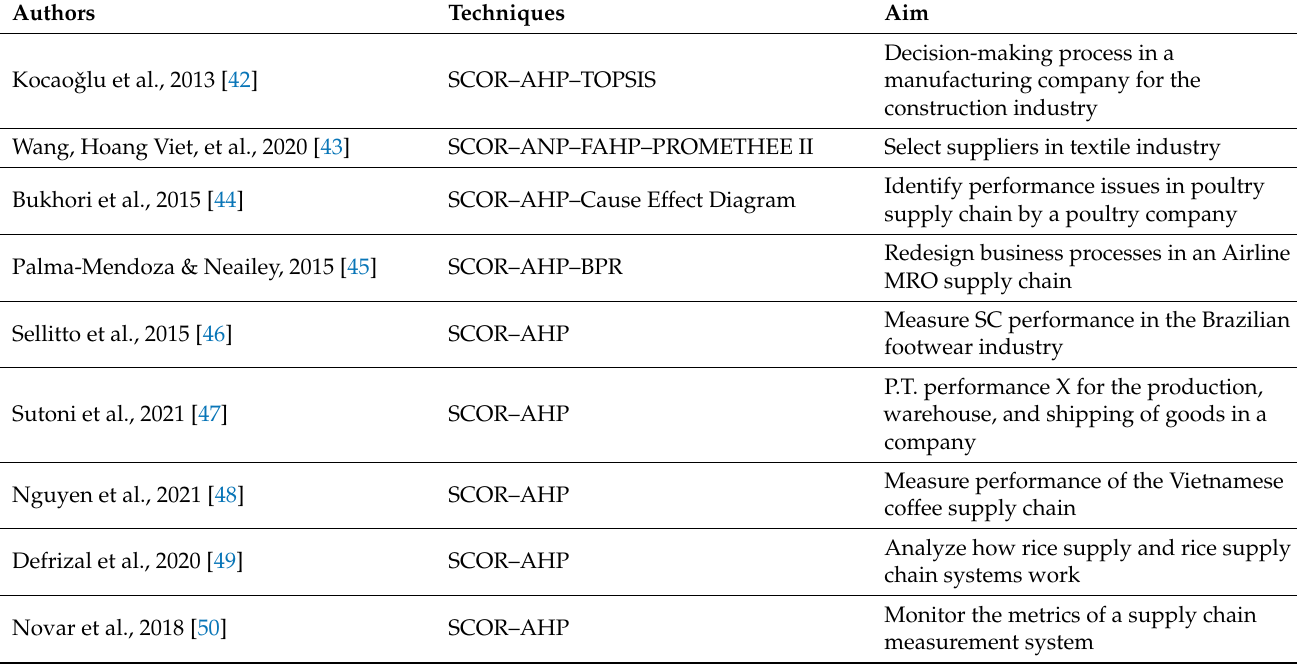
Table 2. Table 2. Research using both the SCOR model and AHP approaches to improve supply chain